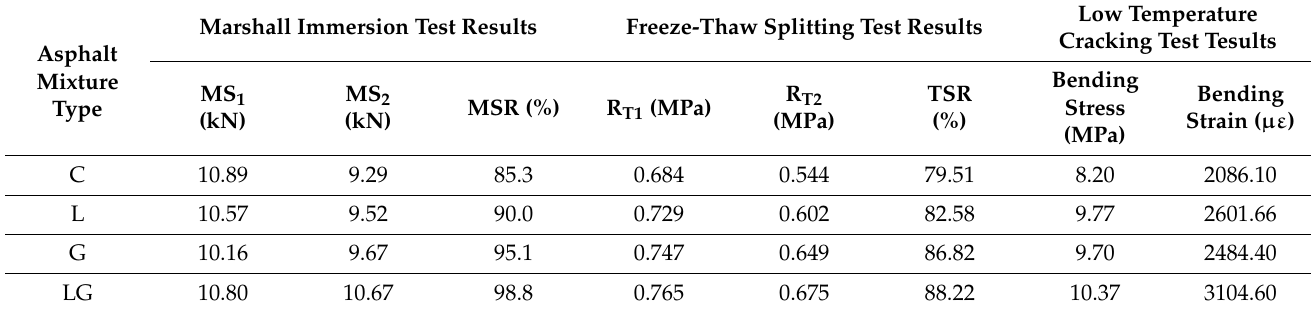
Table 1. Experimental results of different asphalt mixtures